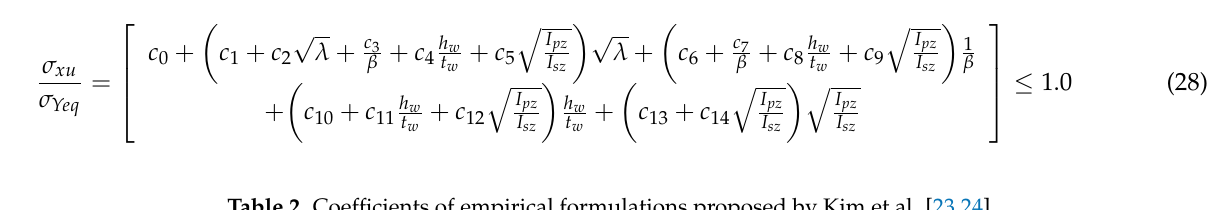
Table 2. Coefficients of empirical formulations proposed by Kim et al.